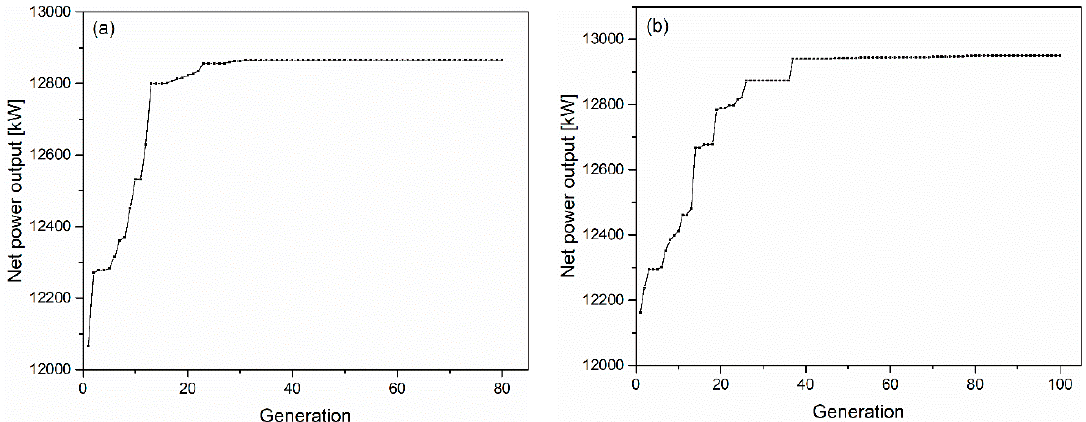
Figure 8. Variation of objective function value with generation for CO 2 -TC+OTC ( a ) R134a, ( b ) Pentane.